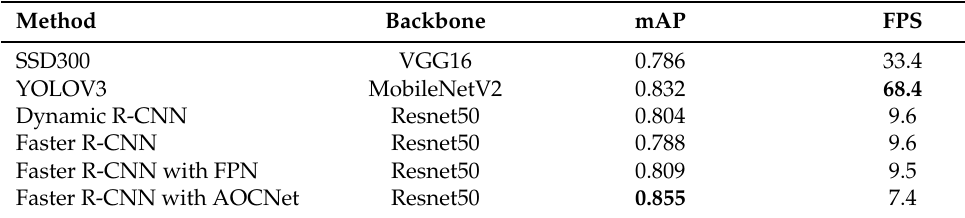
Table 4. The performance of various methods on the NWPU VHR-10 dataset.